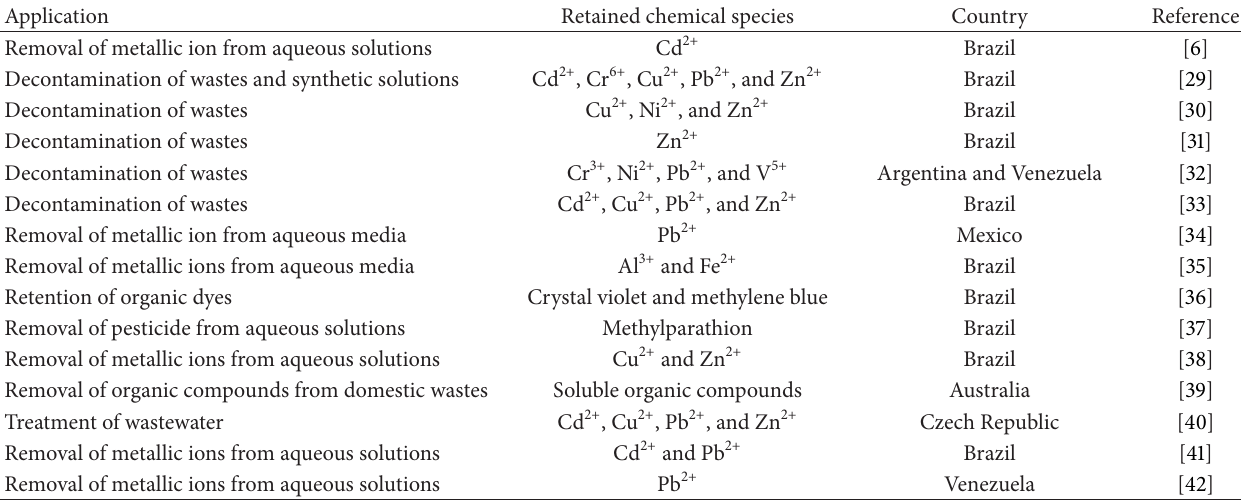
Table 1: Application of vermicompost for treating